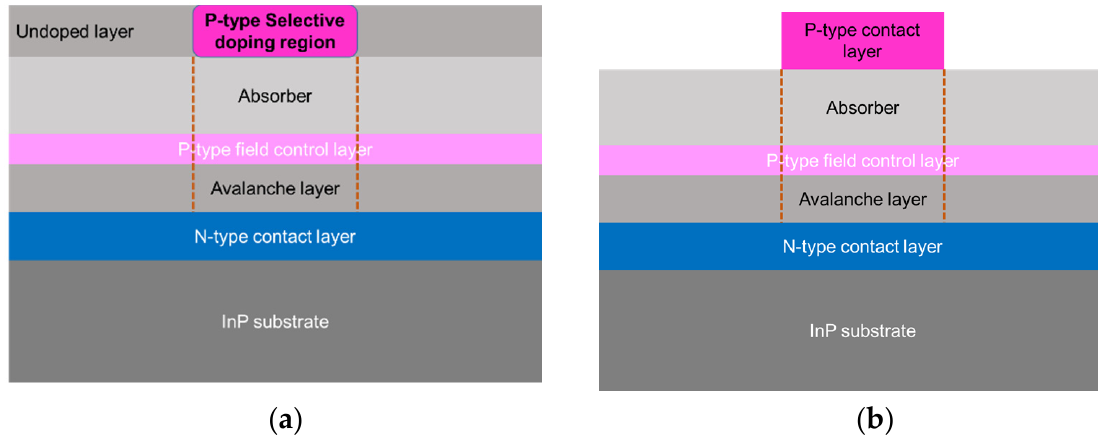
Figure 2. Schematic cross-sections of avalanche photodiodes (APDs) with ( a ) a selective doping structure and ( b ) an etched mesa structure, both for ensuring reliability.